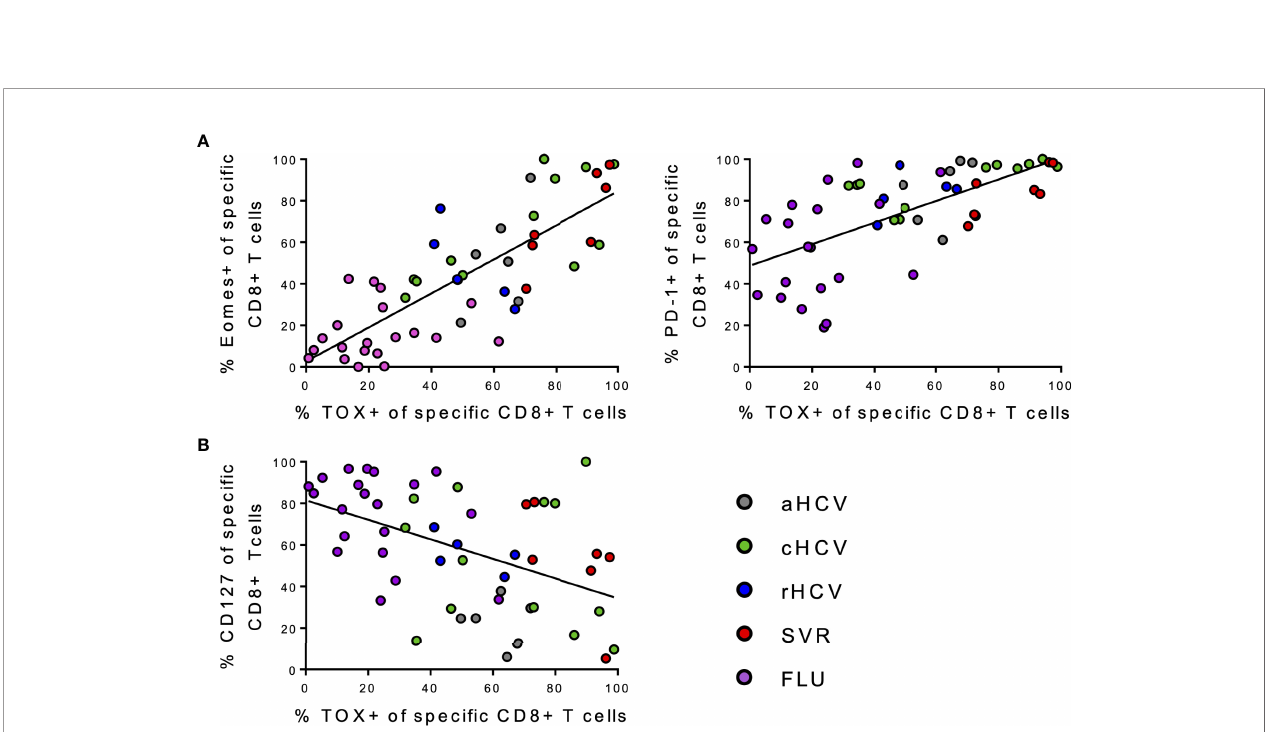
FIGURE 6 | (A, B) Correlation analysis of the indicated markers regarding all individual virus speci fi c CD8+ T cells samples included in the study. (A) Correlations between frequencies of Eomes+, PD-1+ virus-speci fi c CD8+ T cells, and frequencies of TOX+ virus-speci fi c CD8+ T cells. (B) Correlations between frequencies of CD127+ virus-speci fi c CD8+ T cells and frequencies of TOX+ virus-speci fi c CD8+ T